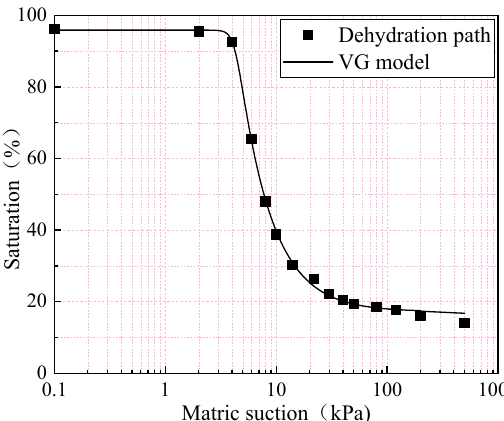
Figure 7. Prediction SWCC curve of VG model.